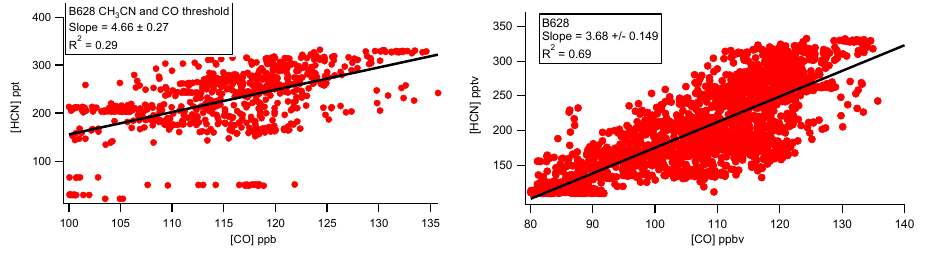
Fig. 5. In plume HCN:CO ratio from flight B628 using the 6-sigma HCN approach and the 175ppt CH 3 CN and 100ppb CO thresholds.